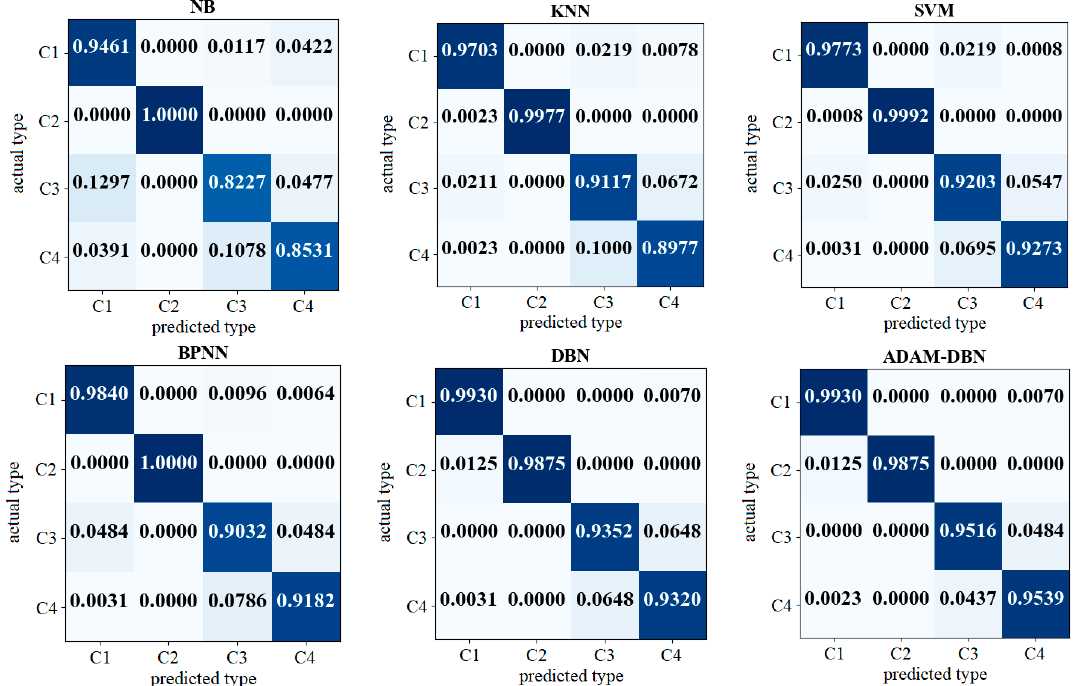
Figure 8. Confusion matrix of insulation recognition results.